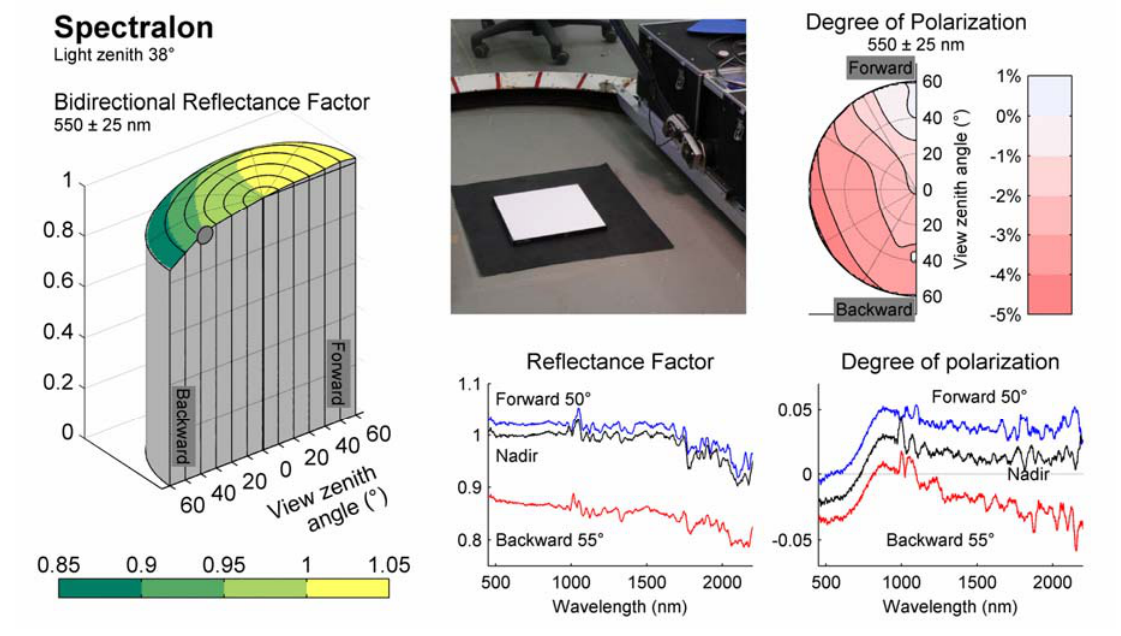
Figure 7. Reflectance properties of white Spectralon panel at 38° illumination zenith angle. (Top middle) Photograph of the target (Left) Bidirectional reflectance factor of Spectralon at a green spectral band as a function of view direction. (Bottom middle) Reflectance factor spectrum at three view angles on the principal plane. (Top right) Degree of polarisation ({ H - V}/{H + V} ) of reflected light at a green spectral band as a function of view direction. (Bottom right) Degree of polarisation spectrum at three view angles on principal